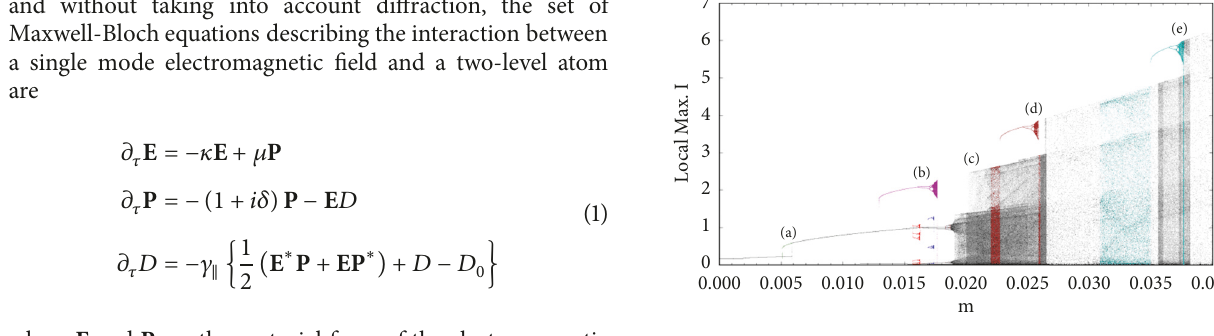
Figure 1: Bifurcation diagram showing the Intensity local maxima, I, as a function of the modulation amplitude, m. The parameters corresponding to the figure are Ω = 3.79 10 −2 , 𝛿 = 1 , 𝜅 = 9.0 10 −2 , 𝜇 = 2.5 10 −5 , 𝛾 = 2.5 10 −5 , 𝐷 = 7200 , and Δ𝜙 = 0 . Note that ‖ 0 0 𝐷 = 3600 corresponds to the laser threshold. We use parameters 0 corresponding approximately to solid state lasers. We recognize five interesting regions which are marked as (a), (b), (c), (d), and (e) in the